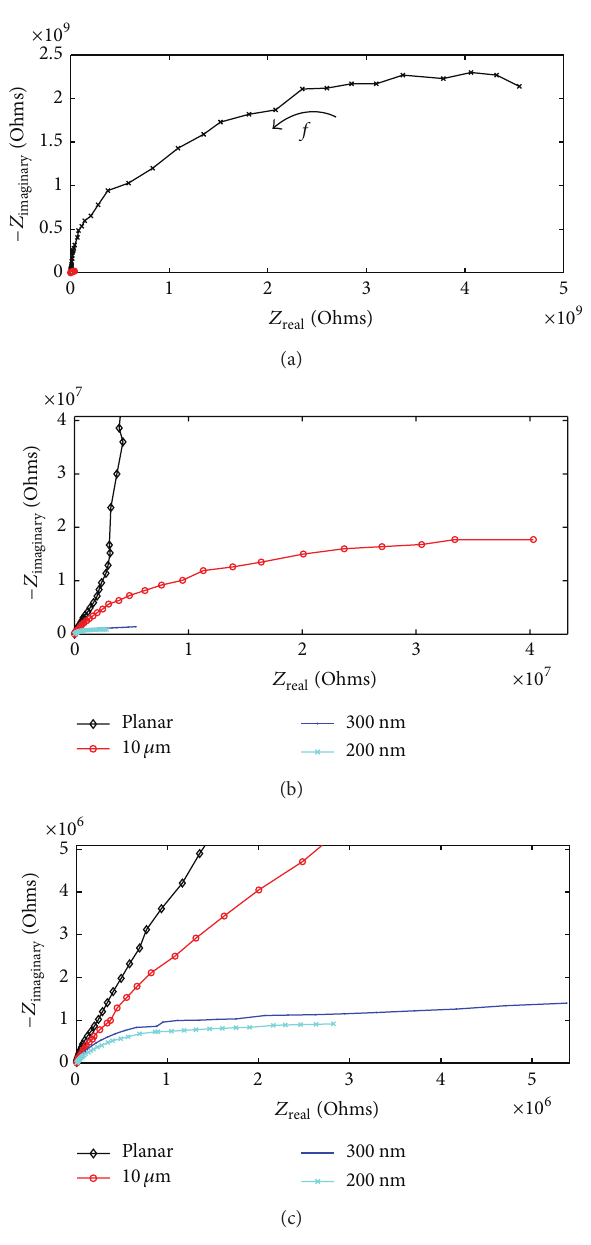
Figure 12: Electrochemical impedance spectroscopy results: (a) comparison of planar and patterned electrodes (10 𝜇 m, 300 nm, and 200 nm) on the same scale. Direction of arrow indicates increasing frequency. (b) Rescaled view of impedances to highlight micropatterned electrodes. (c) Rescaled view of impedances to highlight nanopatterned electrodes.